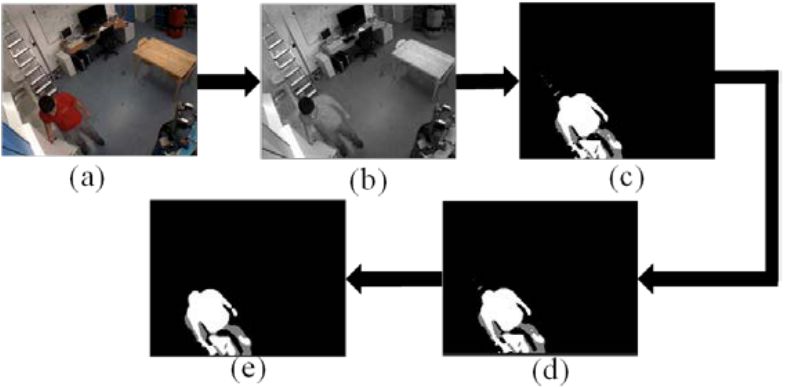
Figure 2. Sample Image of video data preprocessing ( a ) Video frame ( b ) Grayscale image processing image ( c ) Target extraction processing image ( d ) Median filter processing image ( e ) Open operation processing image.